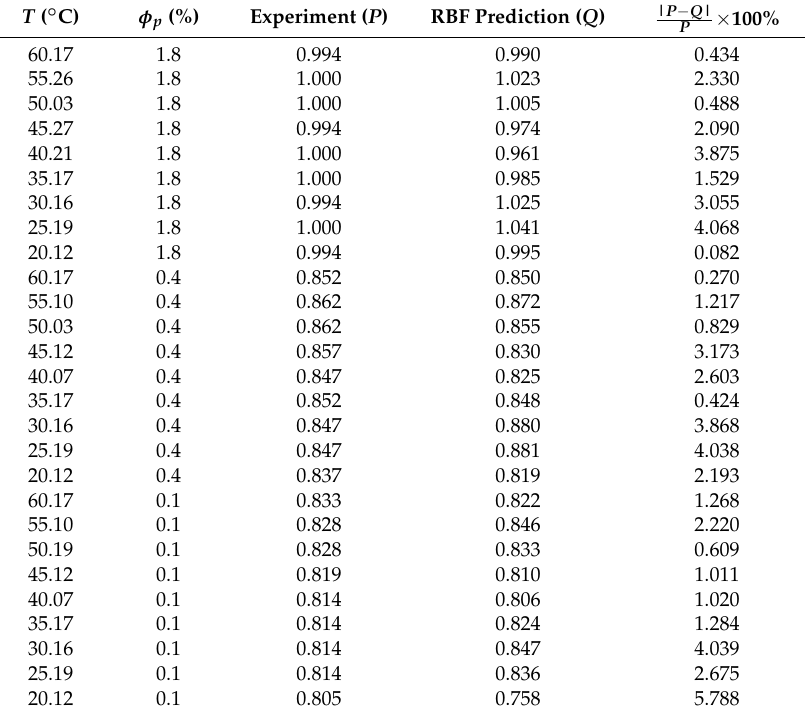
Table 5. Comparisons of the RBF predicted viscosity ratio of TiO 2 -ethylene glycol nanofluids with the experimental data of Chen et al. [12].